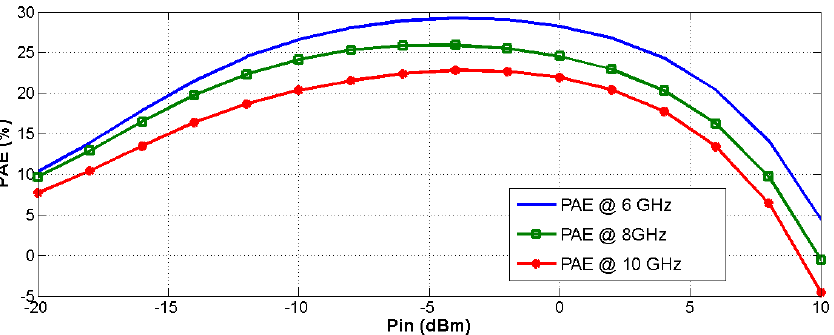
Figure 11. Simulated PAE versus P IN at different frequencies within mentioned band.